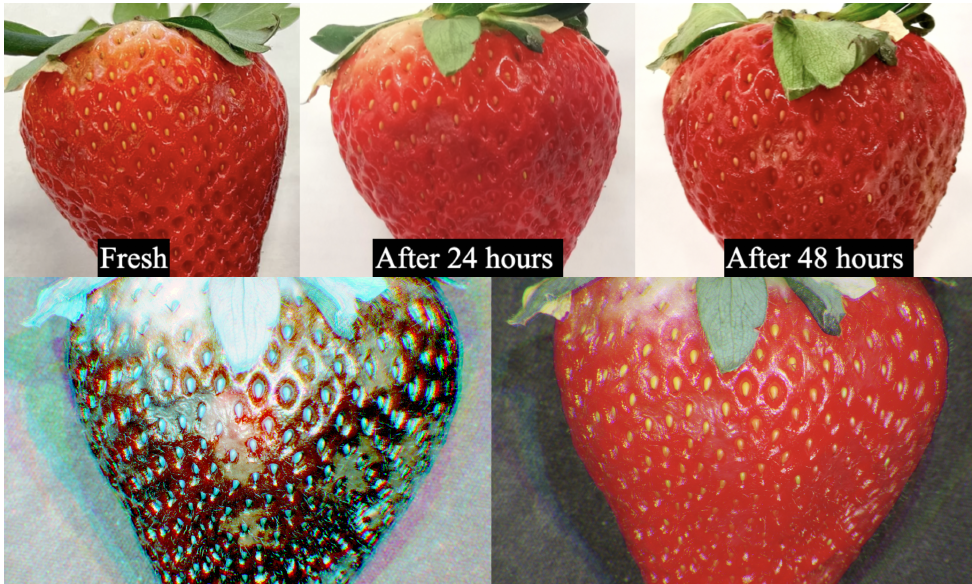
Figure 7. The same strawberry was taken by an RGB camera and active hyperspectral camera. The first row shows pictorial comparisons of the conditions in terms of fresh ( left ), post-24 h ( middle ), and 48 h ( right ) of the same strawberry specimen from a supermarket captured by an RGB camera.